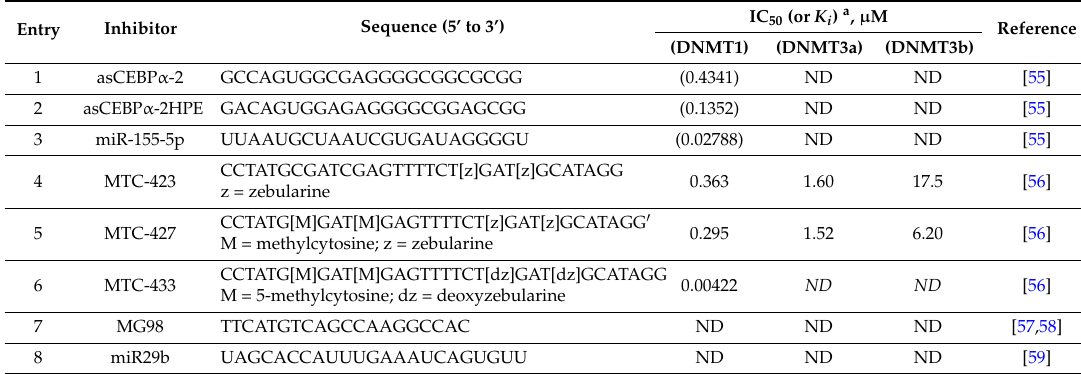
Table 2. Examples of oligonucleotide-based